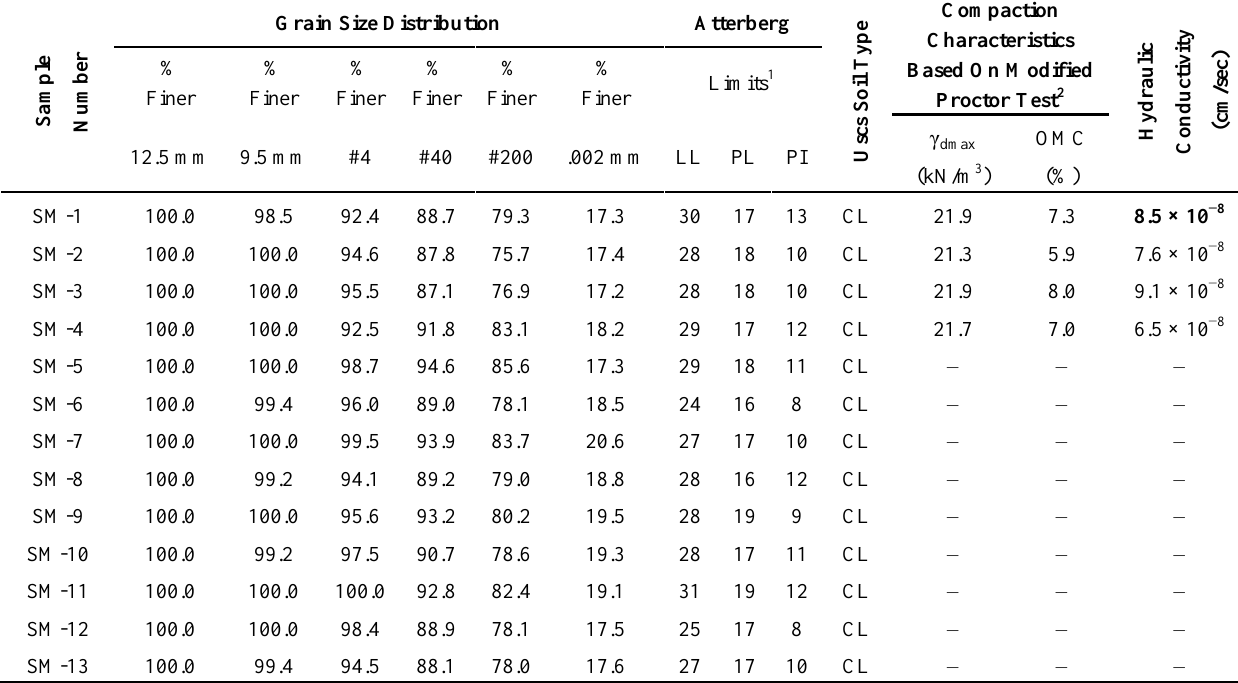
Table 2. Geotechnical characteristics of SM-samples selected for further processing.